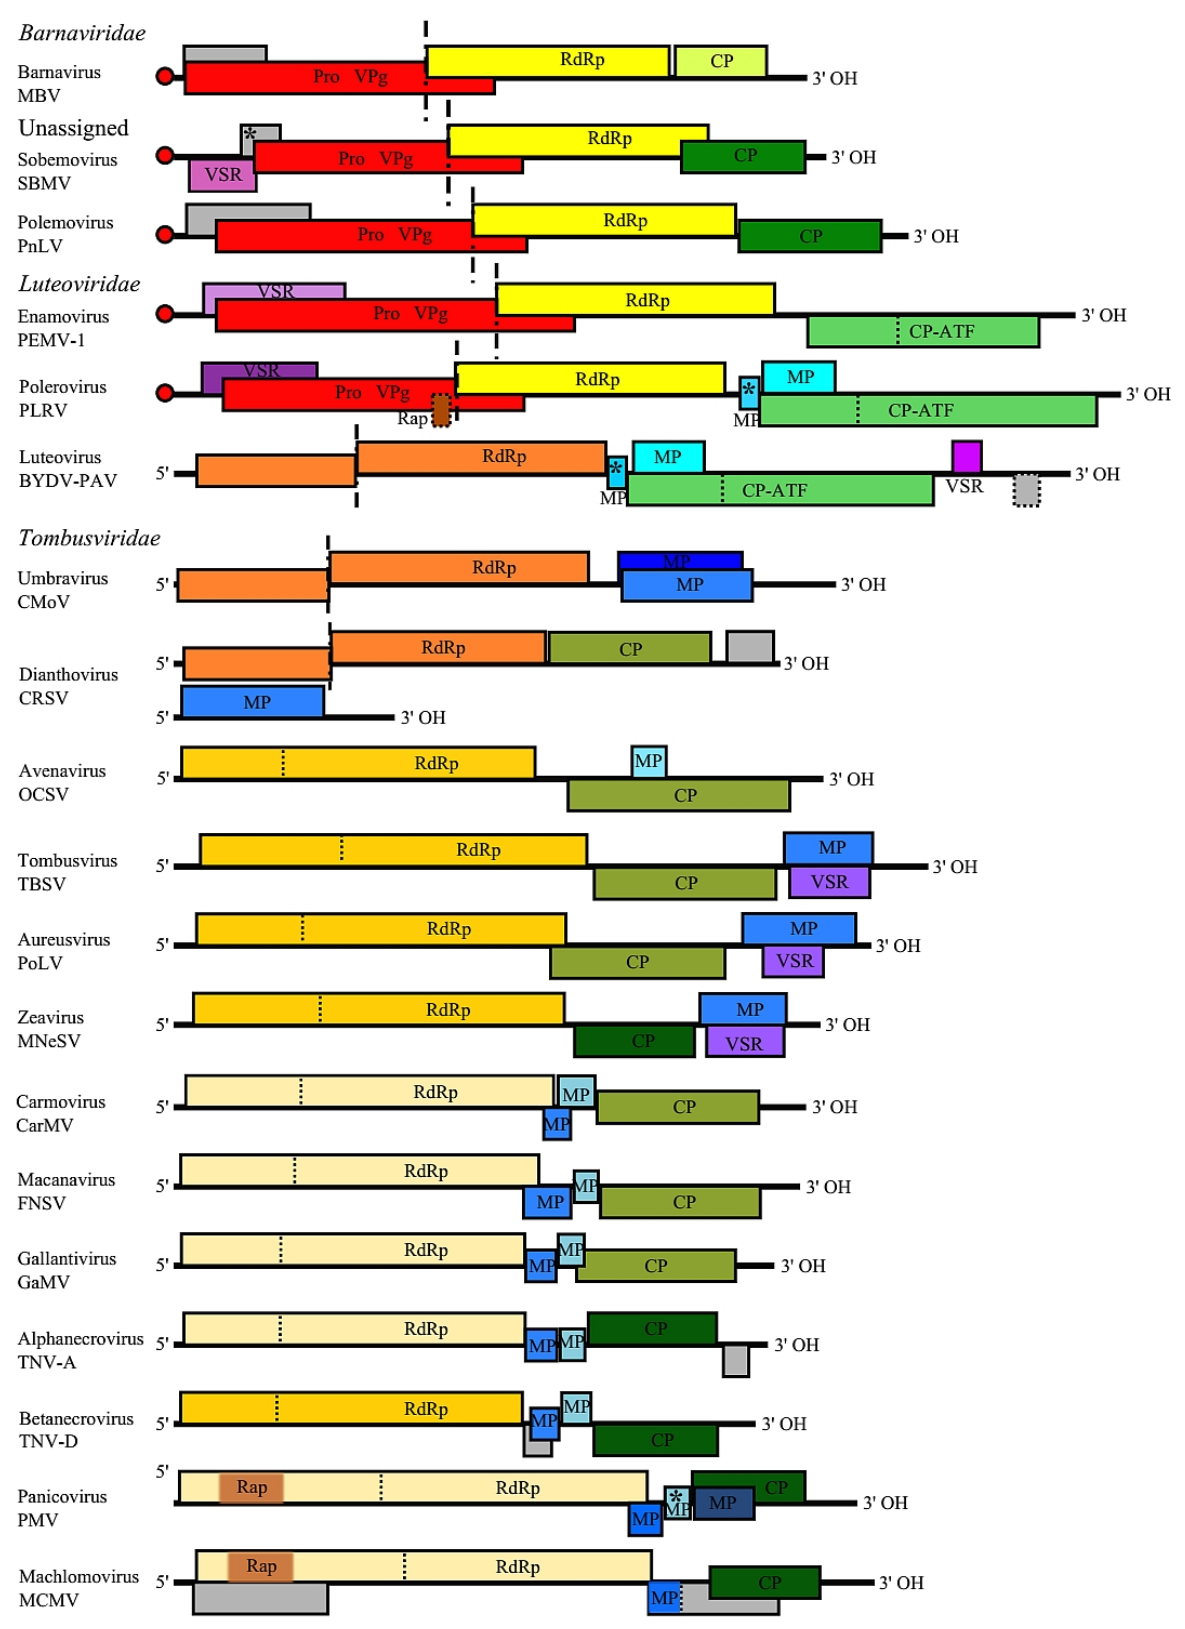
Figure 5. Genome annotations of the type species of phylogenetically related families and genera. NCBI species RefSeqs were used for making annotations. Polero- and luteovirus annotations were corrected according to [239]. Panicovirus annotation was corrected